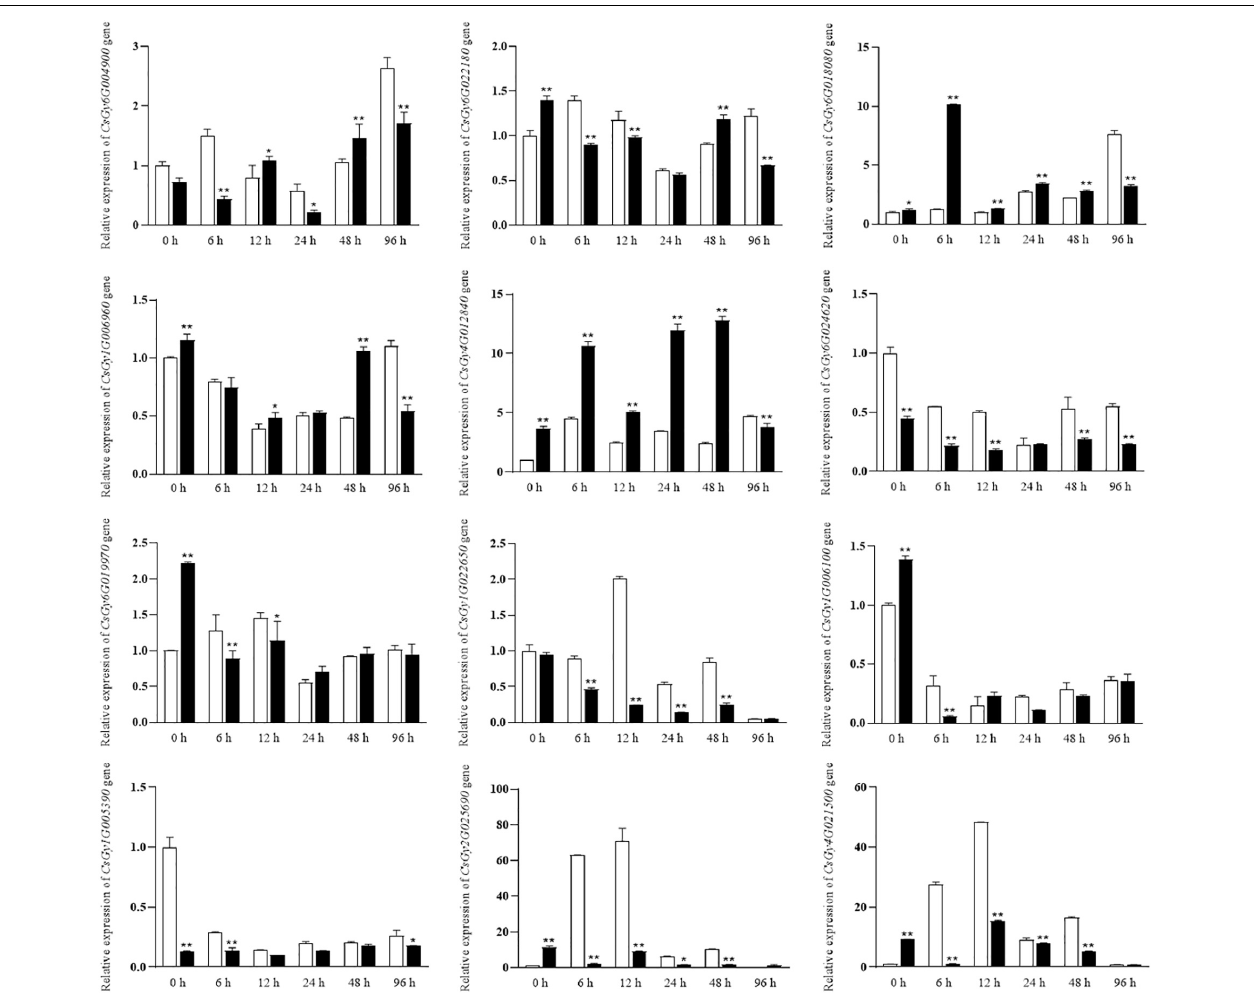
FIGURE 8 | Expression analysis of select DEGs at 0, 6, 12, 24, 48, and 96 hpi using the 2 – (cid:49)(cid:49) Ct method. Data are means ± SD of three biological replicates per variety. Significance was determined by Duncan’s multiple range test, and is represented by * P ≤ 0.05 and ** P ≤